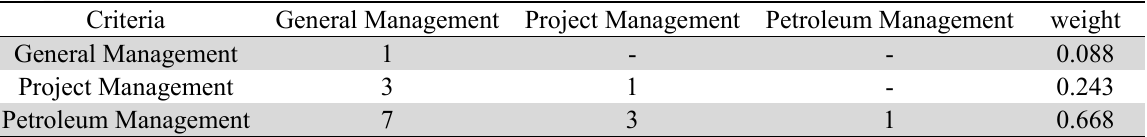
Comparisons in first level